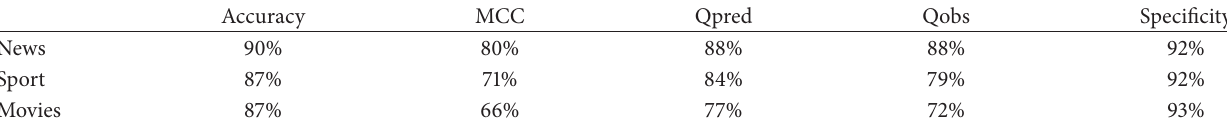
Table 2: The accuracy and MCC for each